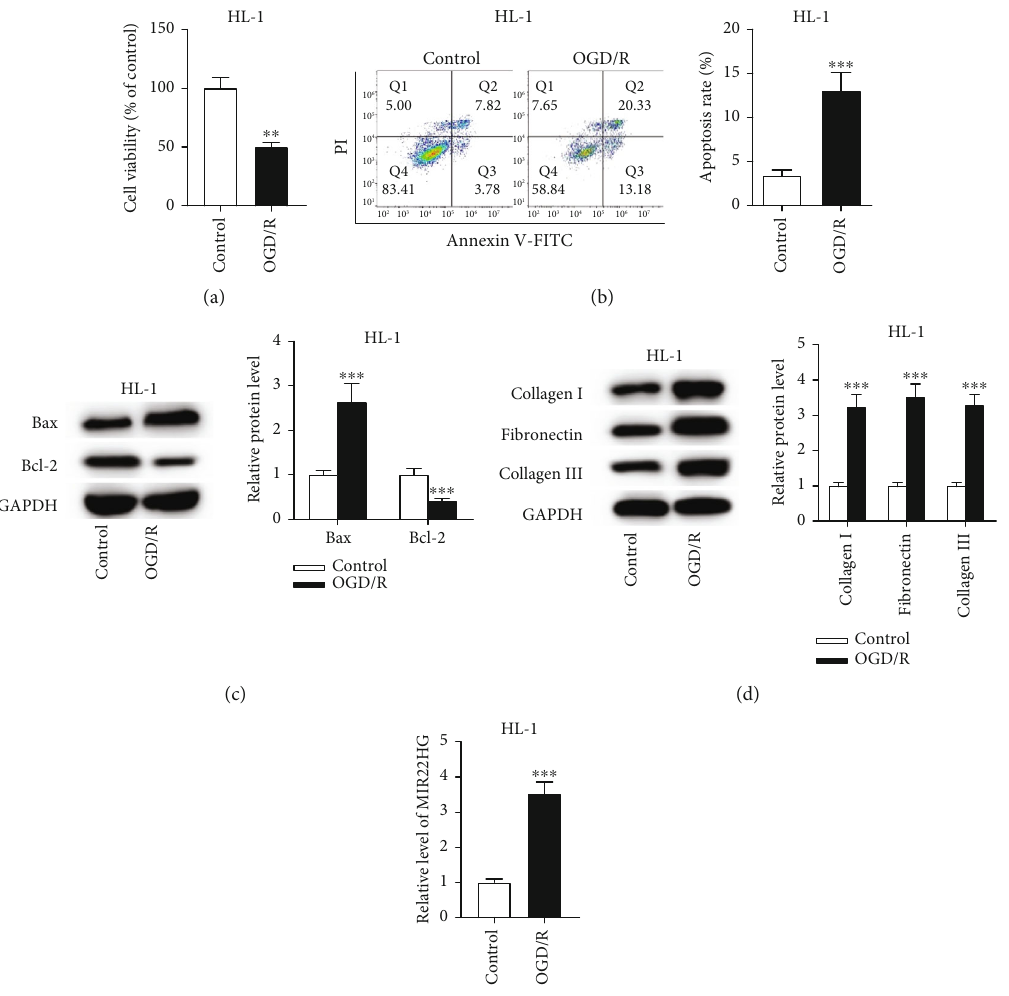
Figure 1: The treatment with OGD/R promotes cell apoptosis and ECM accumulation in HL-1 cells. (a) The viability of HL-1 cells treated with or without OGD/R was measured by CCK-8 assay ( n = 3 ). (b) The apoptosis rate of HL-1 cells treated with or without OGD/R was determined by fl ow cytometry analysis ( n = 3 ). (c and d) The protein levels of Bax, Bcl-2, collagen I, fi bronectin, and collagen III protein levels in HL-1 cells were measured by western blotting analysis ( n = 3 ). (e) The expression level of MIR22HG in OGD/R-treated HL-1 cells was measured by RT-qPCR analysis ( n = 3 ). ∗∗ p < 0 : 01 , ∗∗∗ p < 0 : 001